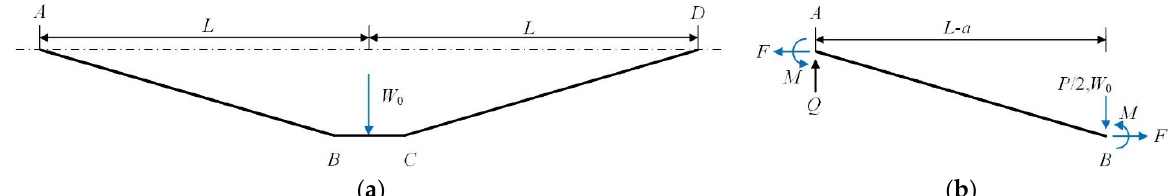
Figure 1. Schematic diagram of a fully clamped sandwich beam with fiber metal laminate face sheets and metal foam core transversely loaded by a flat punch at midspan.